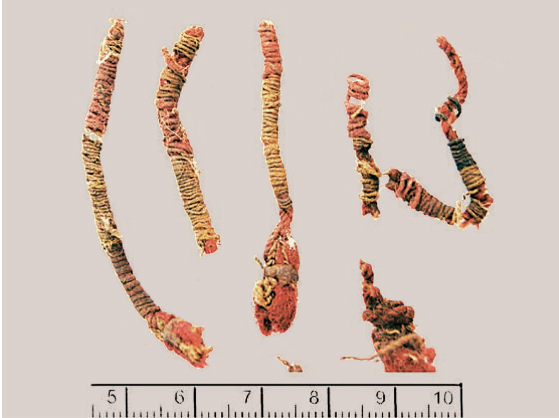
Figure 5 Dyed tassels from Timna‘ Site 34 (Ben-Yosef 2016,